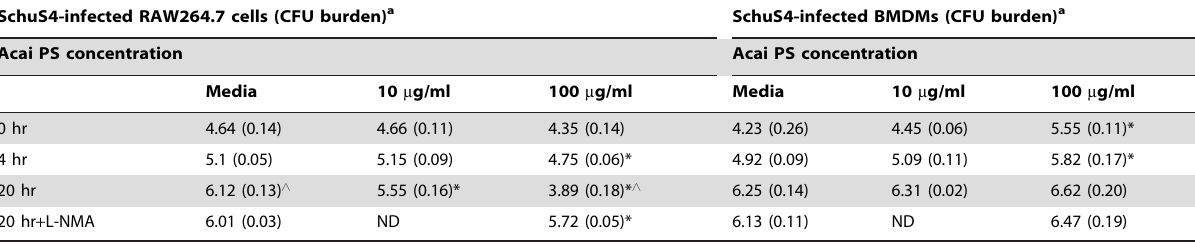
SchuS4-infected RAW264.7 cells (CFU burden)